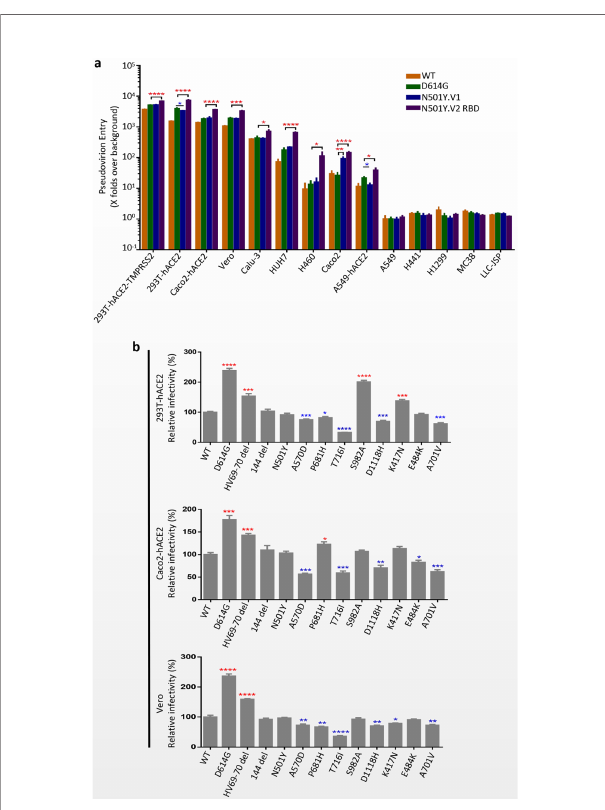
FIGURE 2 | Infection ef fi ciency of SARS-CoV-2 variants N501Y.V1 and N501Y.V2 in mammalian cell lines. (A) Infection ef fi ciency of SARS-CoV-2 WT, D614G, N501Y.V1 and N501Y.V2 RBD variants in human and animal cell lines. (B) Infectivity analysis of N501Y.V1 and N501Y.V2 RBD single-site mutants. N501Y.V1 and N501Y.V2 RBD single-site mutants conducted in 293T-hACE2 (top), Caco2-hACE2 (middle) and Vero (bottom). At 24 h postinoculation, transduction ef fi ciency was analyzed by luciferase activity in cell lysates. The infection ef fi ciency of viruses was calculated by dividing the RLU values by the mean SARS-CoV-2 WT RLU. Experiments were done in 4 replicates and repeated at least twice. One representative is shown with error bars indicating SEM. The signi fi cant changes were marked with colored symbols, red stars for increased, blue stars for decreased. ns represents no signi fi cant difference, p < 0.05 (*), p < 0.01 (**), p < 0.001 (***), p < 0.0001